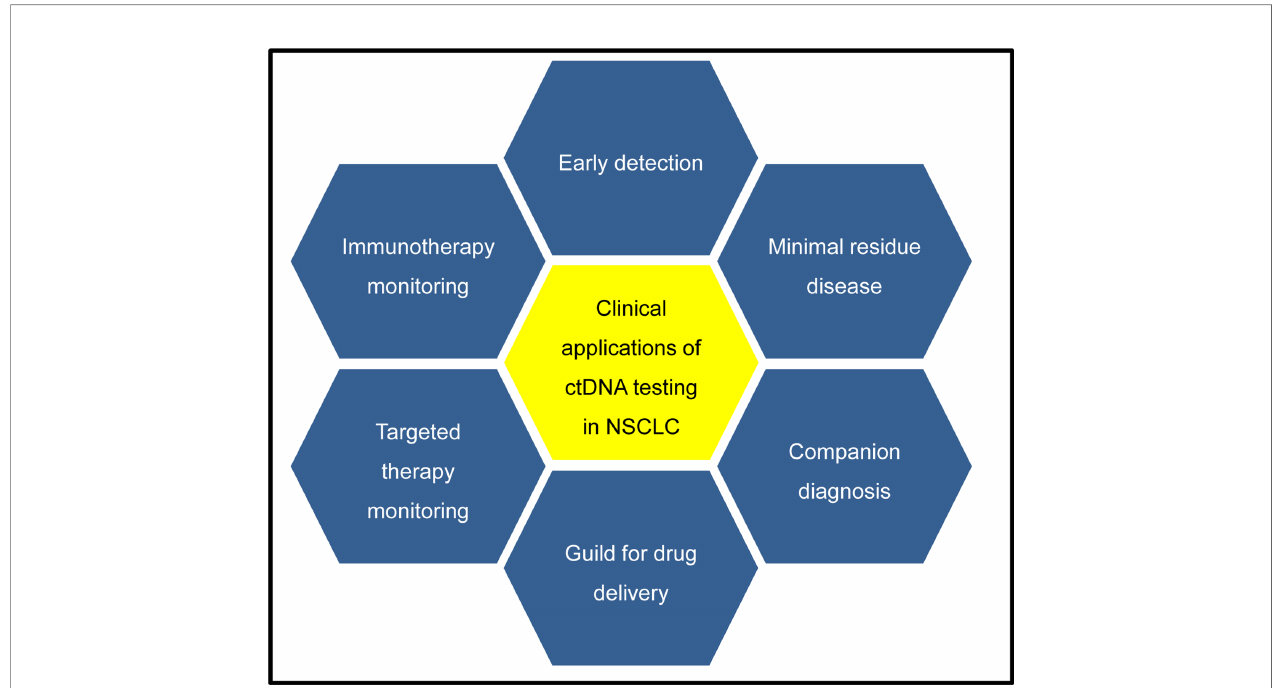
FIGURE 2 | Potential clinical applications of ctDNA testing in NSCLC patients. CtDNA testing in early tumors detection are under development, which may identify patients with cancers at early stage when they are more likely to be curable. CtDNA testing in minimal residual disease detection after surgery can provide the evidence of tumor relapse, which may offer an opportunity for early intervention for patients according to risk of recurrence. For companion diagnosis, ctDNA testing is available to identify many somatic alterations, which can provide a guide for treatment decisions for patients with targeted therapies. Analysis of cfDNA has been used to monitor the response to targeted or immunotherapy, which can provide a molecular basis to guide the subsequent therapy